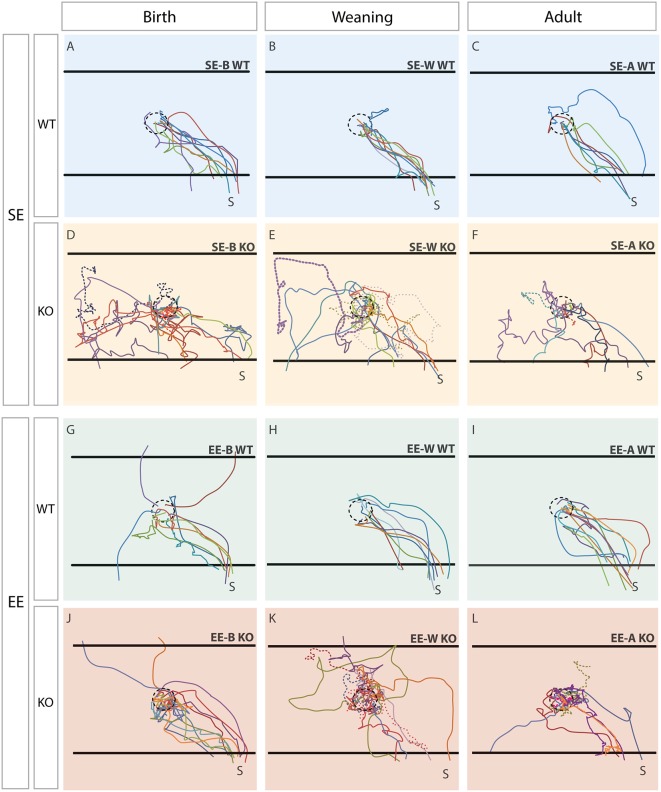
Trajectories reveal clear differences between genotypes which are corrected in Ten-m3 KOs following enrichment from birth. Traces show paths taken by individual mice. The trajectory of each mouse within a group is shown in a different color. The location of the dish containing the sunflower seed (starting point; see “Materials and Methods” section) is shown by the dotted circle in the center. The black horizontal lines at the “top” and “bottom” of each panel show pre-defined escape areas (see “Materials and Methods” section). Figures are oriented such that the shelter (S) is located in the bottom right corner. Each column represents a different age-group (birth, weaning, adult). The top row (A–C) illustrates trajectories of the standard-housed (SE) WT mice in each age group. All SE WTs displayed clear and efficient escape trajectories towards the shelter. The second row (D–F) shows SE KO mice. All SE KOs behaved very differently to WTs, tending to explore the cage extensively after the presentation of the stimulus. The trajectories of mice which did not reach an escape area within the time limit are shown by dotted lines. The third row (G-I) shows the trajectories of the WTs which experienced EE at some stage. These mice generally moved similarly to standard-housed WT mice, although three of the group which experienced EE from birth (EE-B WTs; G) fled initially to the “top” and “bottom” escape areas of the arena, rather than to the shelter directly. The bottom row (J–L) shows the trajectories of the EE KO mice. The KOs enriched from weaning or adulthood tended to exhibit random trajectories, similar to the standard environment control for weaning (SE-W) and adult group (SE-A) KOs. The EE-A KOs tended to hover around the center rather than heading to the exit. The trajectories of EE-B KOs (J), however, appear much more similar to the paths taken by EE-B WTs than to those exhibited by standard environment control for birth group (SE-B) KOs, suggesting a recovery of visually-mediated behavior following EE from birth in Ten-m3 KOs.